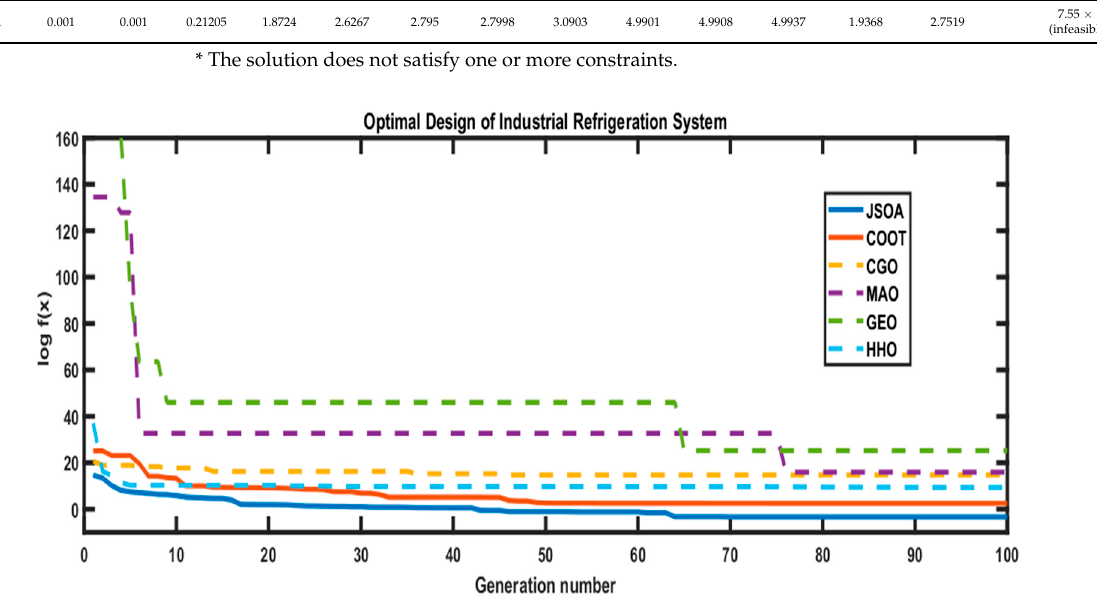
Figure 13. Convergence graph of the Optimal Design of an Industrial Refrigeration System. The dotted line represents an infeasible solution shown by an algorithm.